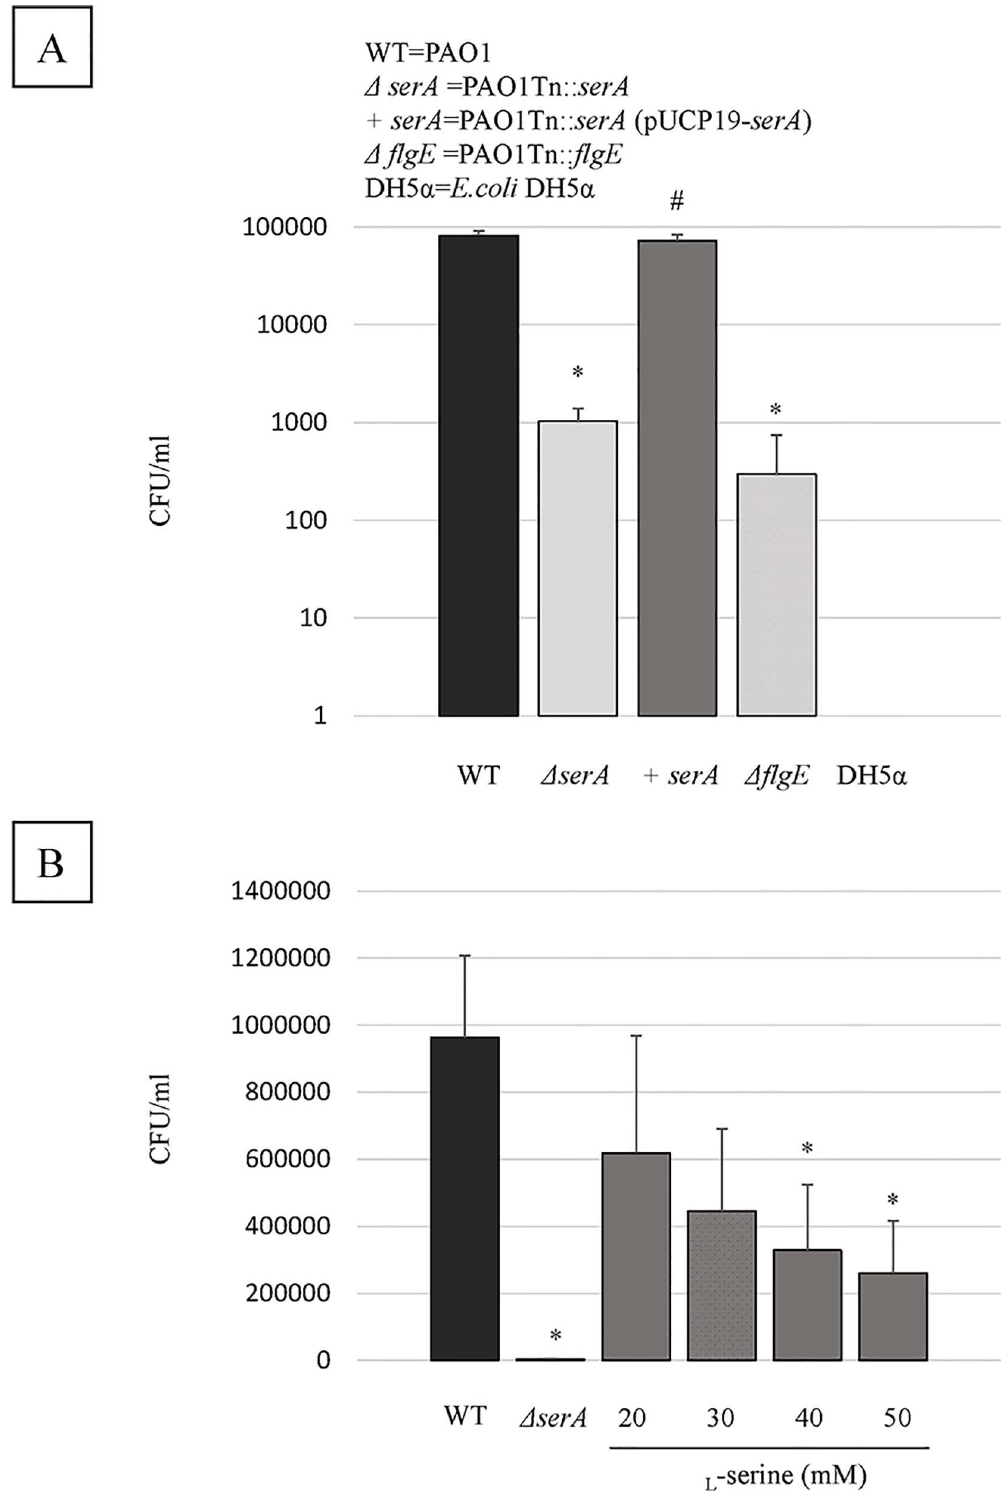
Fig 1. Penetration activity of P . aeruginosa strains. (A) The wild-typestrain (WT), PAO1Tn:: serA mutant ( Δ serA ),PAO1Tn:: serA (pUCP19- serA ) complementary strain (+ serA ), and PAO1Tn:: flgE mutant ( Δ flgE )were inoculated onto the apical surfaces of Caco-2 cell monolayers at an MOI of 100, and the numberof bacteria in